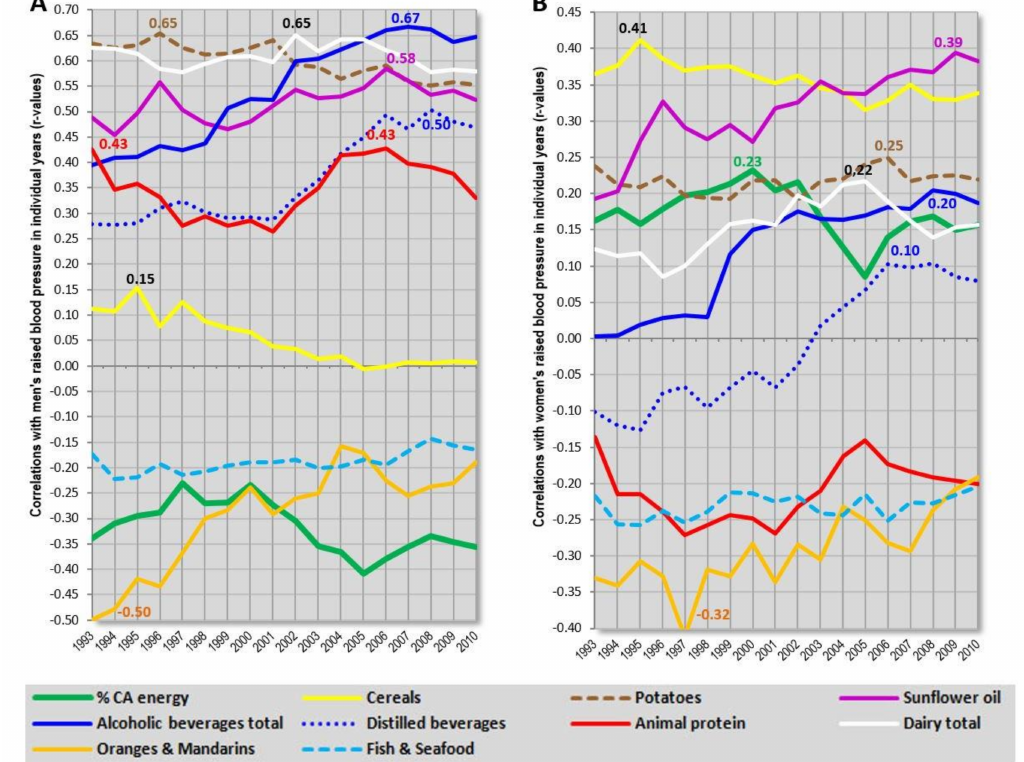
Figure 12. ( A ) Temporal changes in correlation coefficients ( r -values) between men’s raised blood pressure (2010) and 10 food items. Countries with health expenditure of 500–2000 USD per capita ( n = 61); ( B ) Temporal changes in correlation coefficients ( r -values) between women’s raised blood pressure (2010) and 10 food items. Countries with health expenditure of 500–2000 USD per capita ( n = 61); Abbreviations: % CA energy = the mean proportion of energy from carbohydrates and